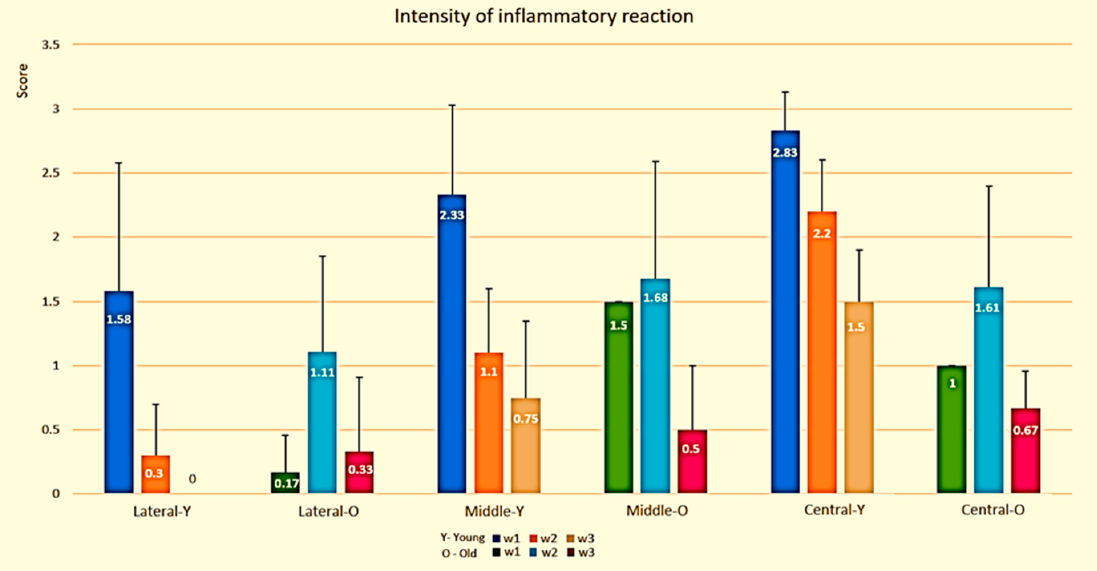
Figure 5. Inflammatory reaction score in the young and old rats along time.